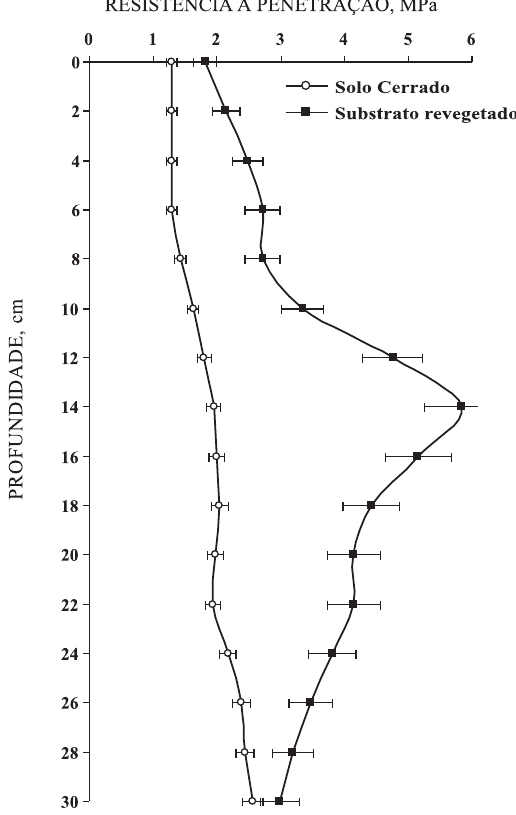
Figura 1. Resistência mecânica à penetração para o substrato revegetado e para o solo sob Cerrado nativo.